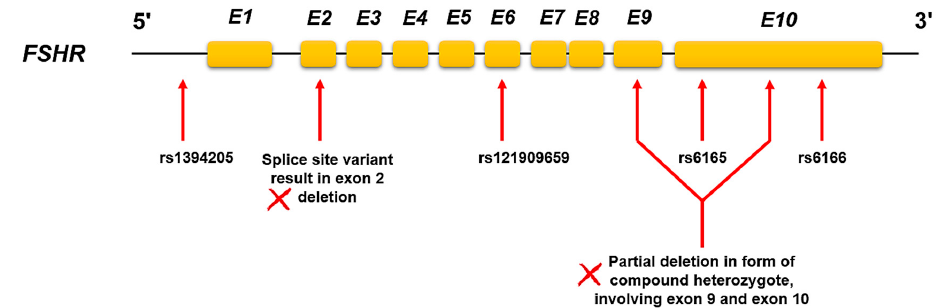
Figure 2. All the actionable and/or functional validated PGx variants in the FSHR gene. Pharmacovariants introduced here are based on clinical reports for changing the ovarian responses observed during infertility treatment procedures in females in different populations (see the text and Table 1 for more details) . FSHR, follicle-stimulating hormone receptor; PGx, pharmacogenomics. Table 1. FSHR gene variations with clinical evidence for pharmacogenetic effects in different populations.